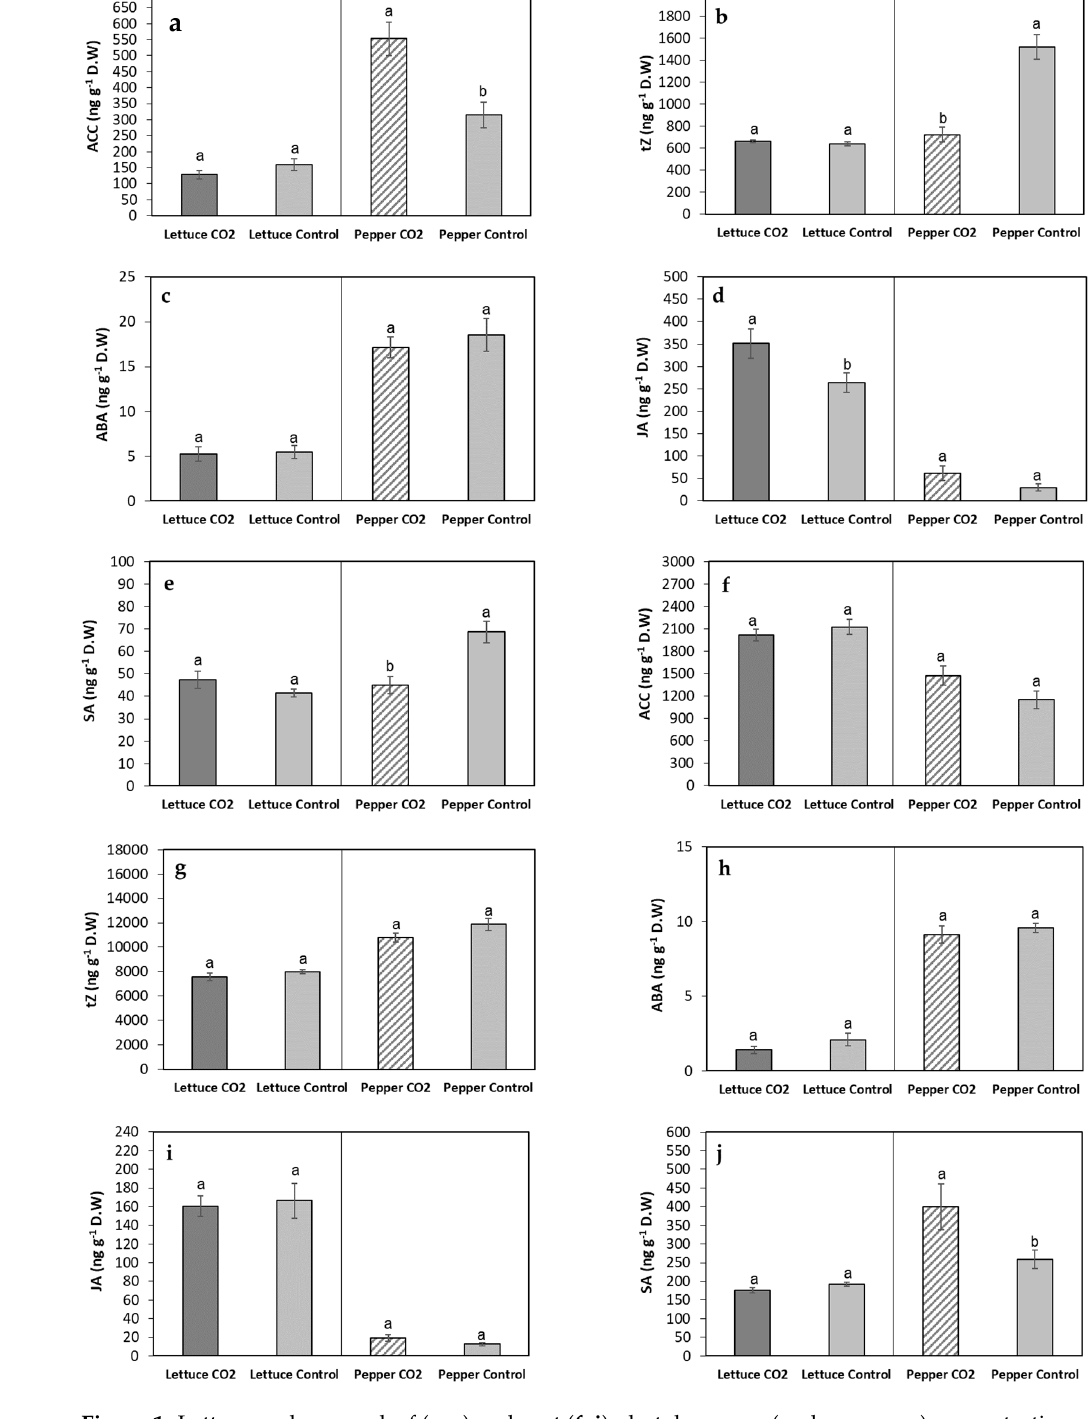
Figure 1. Lettuce and pepper leaf ( a – e ) and root ( f – j ) phytohormone (and precursor) concentrations under high RZ CO 2 and ambient CO 2 . Bars are the mean ± SE of eight replicates, with different letters indicating significant ( p < 0.05) differences within a species.